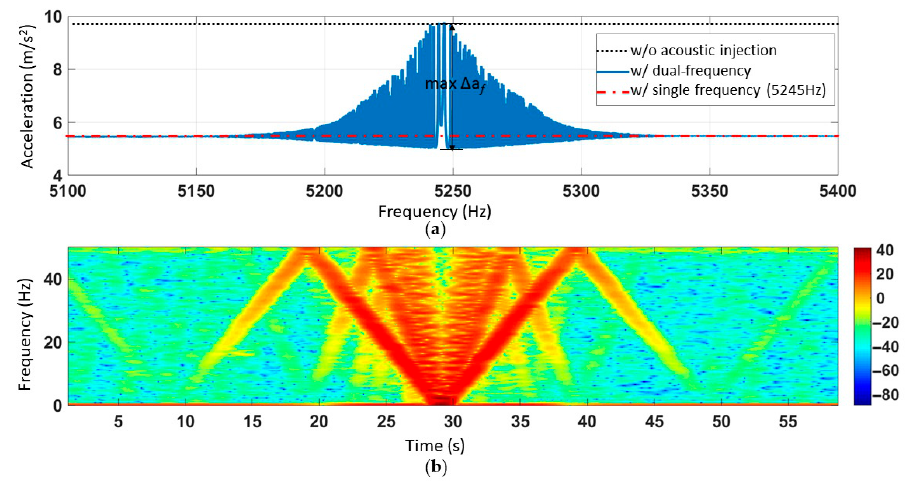
Figure 11. The acceleration of ADXL103 interfered by acoustic injection of superimposed resonant frequency and sweeping frequency. ( a ) Acceleration output of acoustic injection during the experiment. ( b ) Time-frequency response.